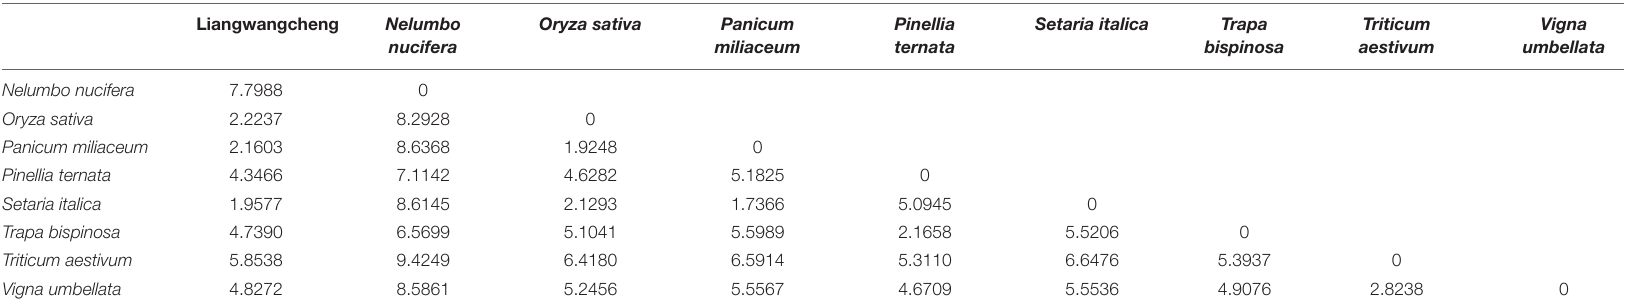
TABLE 2 | Mahalanobis distance matrix of Liangwangcheng and control groups.